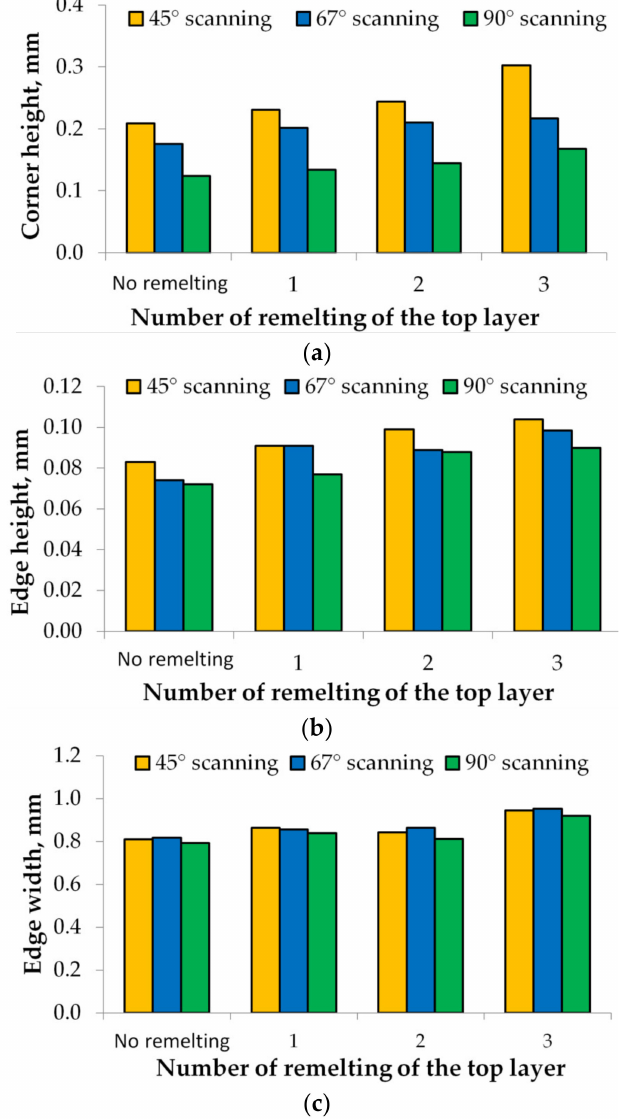
Figure 7. Corner and edge height and width as a function of the remelting passes of the top